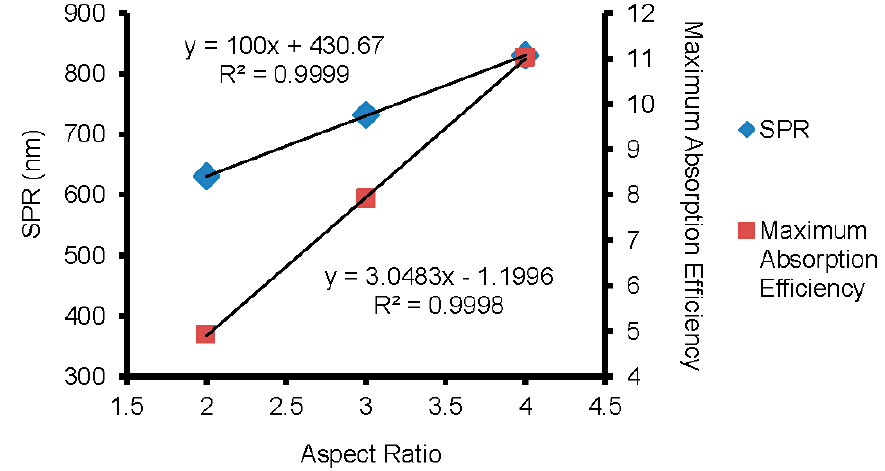
Figure 9. Linear increase of the wavelength of longitudinal surface plasmonic resonance (SPR) and of maximum absorption efficiency with aspect ratio.